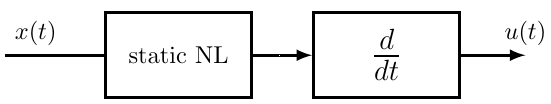
Figure 1. Nonlinear system usually used to model nonlinearities of a guitar pickup